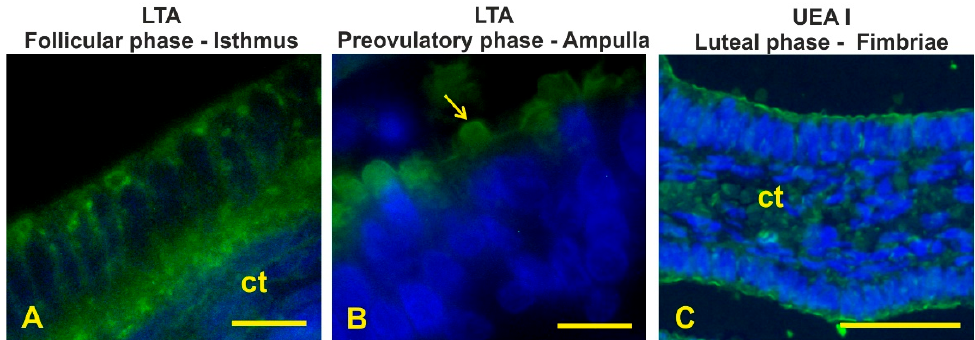
Figure 13. Staining of aL-Fuc terminating glycans with LTA ( A , B ) and UEAI ( C ) in the baboon Papio hamadryas oviductal epithelium. ( A ) LTA positivity of the isthmus during the follicular phase. ( B ) LTA positivity of the ampulla during the preovulatory phase. ( C ) UEA I binding sites in the fimbriae during the preovulatory phase. Note the presence of positive apical blebs in the ampulla from preovulatory baboons. Key: ct, connective tissue; arrow, apical protrusion. Scale bar: ( A , B ) = 10 μ m; ( C ) = 50 μ m.